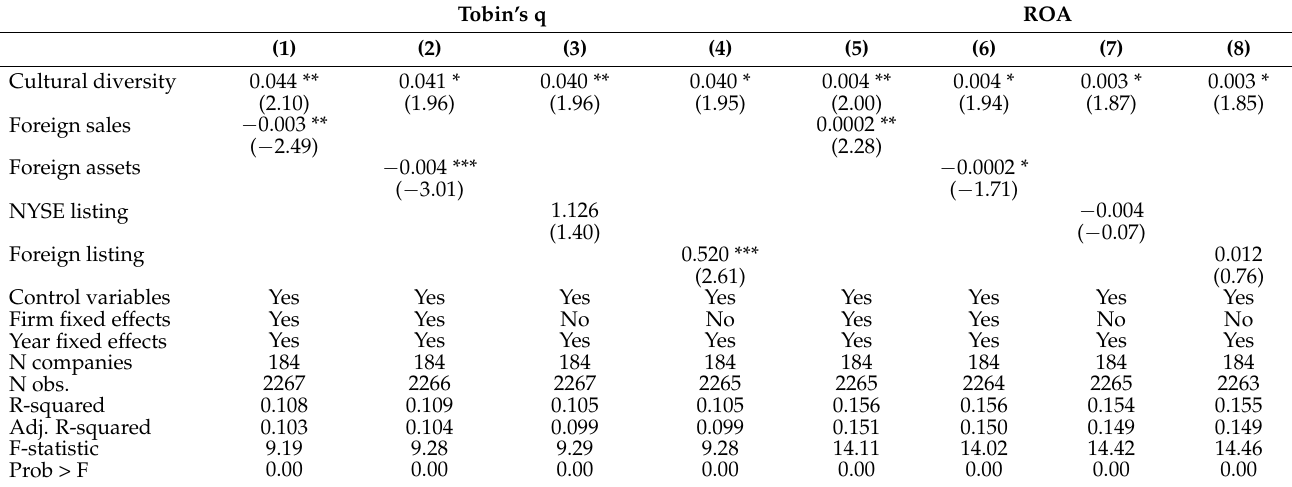
Table 6. Firm’s foreign presence and